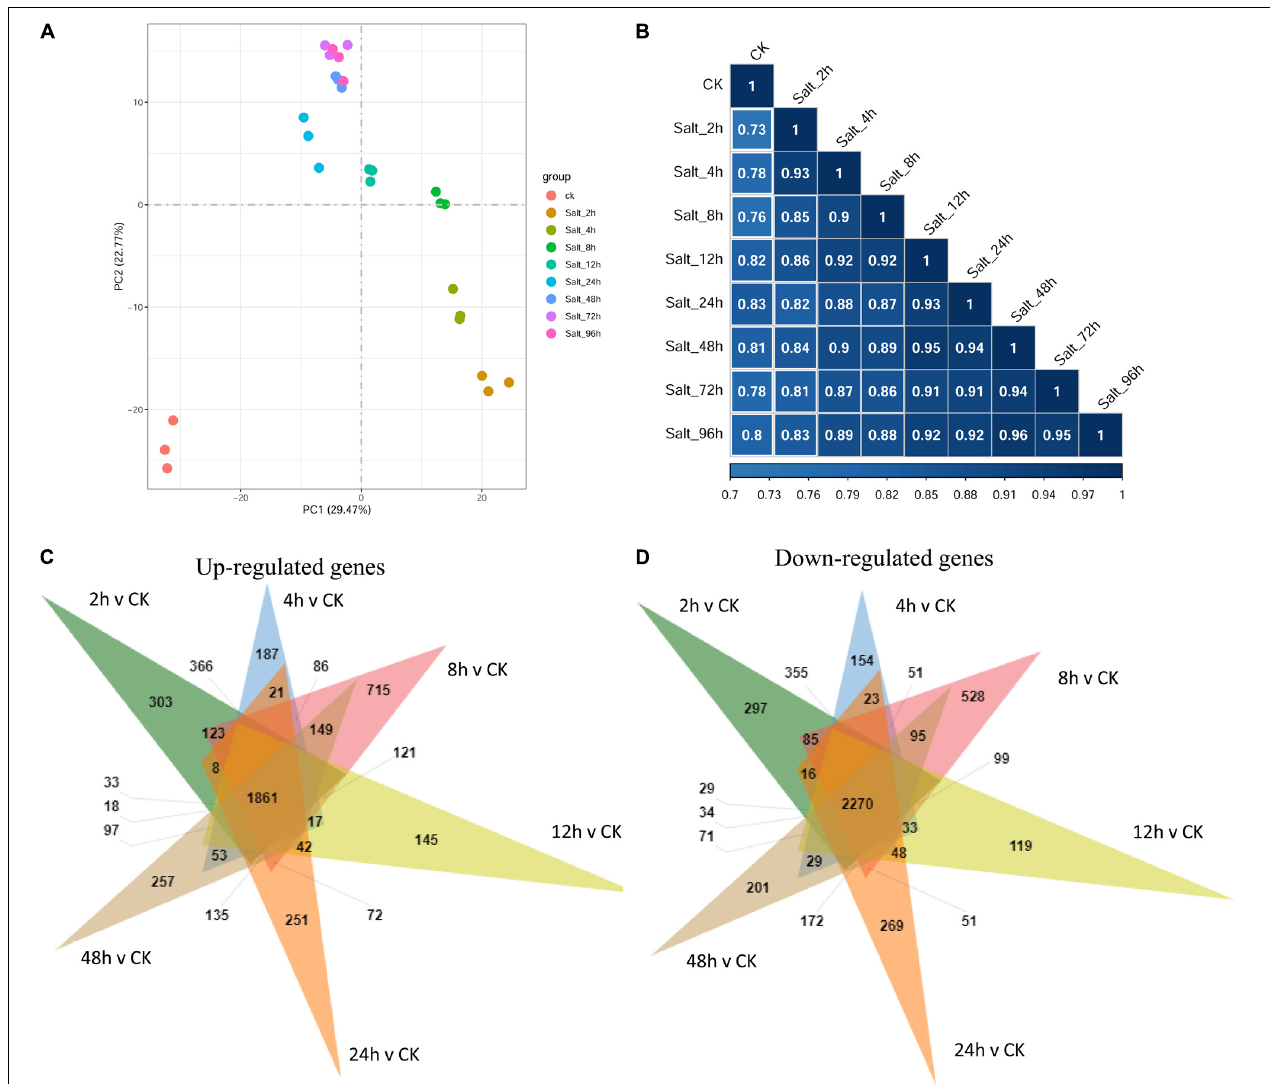
FIGURE 2 | (A) The principal component analysis (PCA) plot and (B) gene expression correlation analysis using whole gene expression profiles of GY-D55 cells in different salt stress treated time points. The PCA shows the global gene expression of control samples was most distinct from the salt stress treated time points; gene expression of 2–24 h NaCl treated samples were scattered; samples of salt stress treated 48, 72, and 96 h clustered together. The correlation analysis indicated that gene expression of control samples was lowly correlated with the salt-treated samples and samples of late time points were highly correlated with each other. PCA, principal component analysis. (C) The Venn analysis result of upregulated genes for each time point compared with control samples. (D) The Venn analysis result of downregulated genes for each time point compared with control